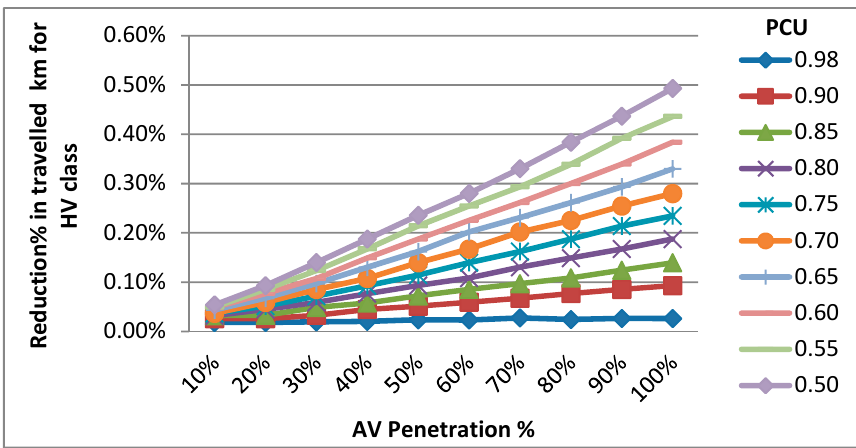
Figure 5. Reduction percent in traveled kilometers for heavy vehicle class. AV spread in the traffic flow also reduces total daily delay significantly of the whole network model, reaching a reduction of 62,881 h for 100% AV penetration and 0.5 PCU equal to 37.87% of base scenario delay. Implementation of AVs with different factors has also increases mean network speed by 4.08%, reaching 45.20 km/h compared to 43.43